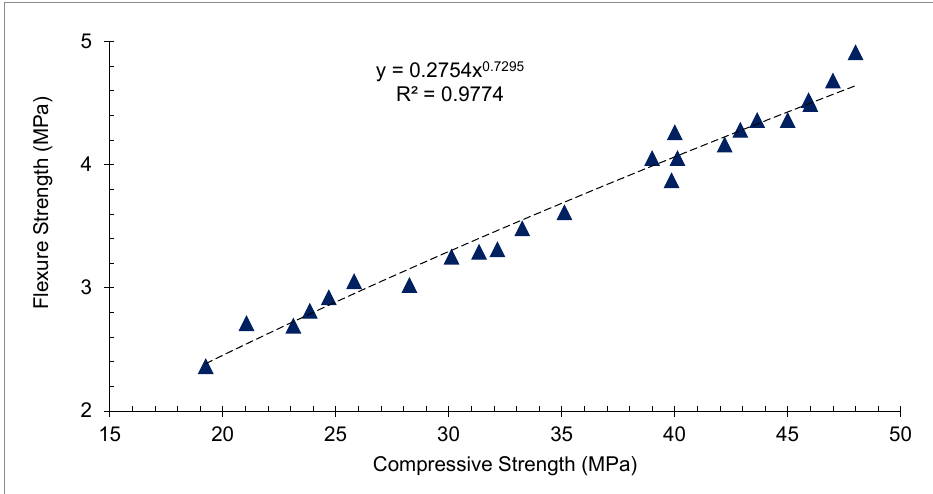
Figure 13. Relative flexural strength of concrete: data source [45]. Figure 14 reveals the correlation between the compressive and flexural capacity of concrete with distinct percentages of CPS at various days of curing. FS is almost 10% to 20% of CMS varying on the mix design of concrete. It can be noticed that the trendline among CMS and FS seems to be straight. Therefore, a strong correlation has occurred among CMS and FS with an R 2 value more than 90%.